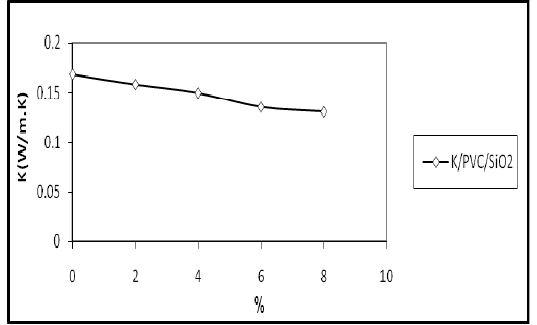
Fig. 4: The thermal conductivity variation curve of PVC micro-composites. Thermal conductivity values of polymer filled SiO composites. 2 Silica`s Ratio